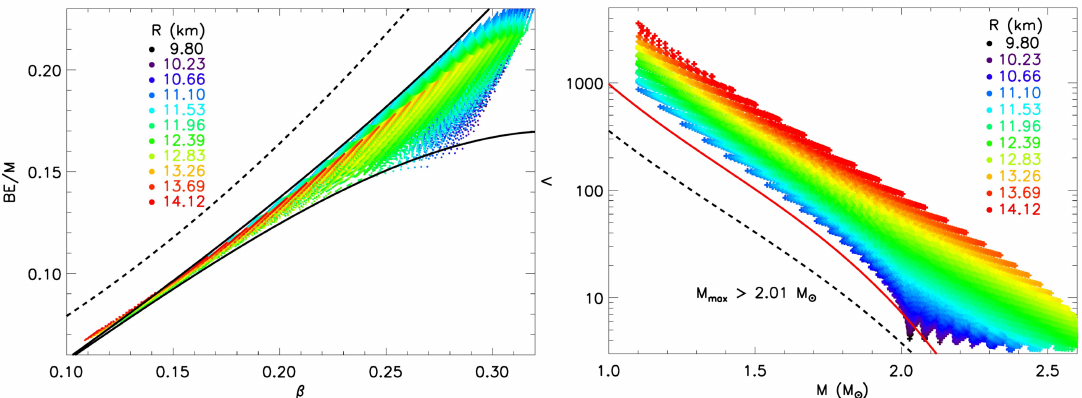
Figure 6. Neutron star properties from piecewise polytropes. Colors indicate radius values. ( Left ) Binding energy per unit mass BE/ M as a function of compactness β . Solid curves denote the bounds in Equation (18) and the dashed curve shows the causal maximum [37]; ( Right ) Dimensionless deformability Λ as a function of M . Dashed lines show the causal minimum assuming M max = 2.01 M (cid:12) [38], and the solid line shows the minimum permitted by the unitary gas constraint